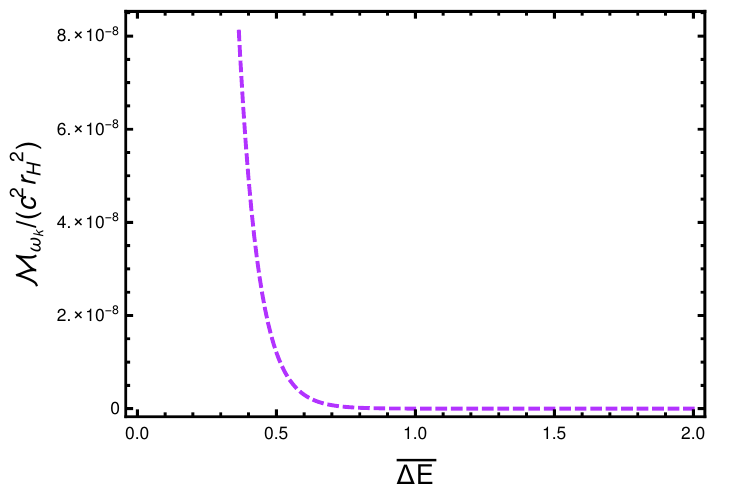
( ρ ) / ( c 2 r 2 ) perceived by two out going null detectors AB H k ∆ E for fixed dimensionless field mode frequency ω H